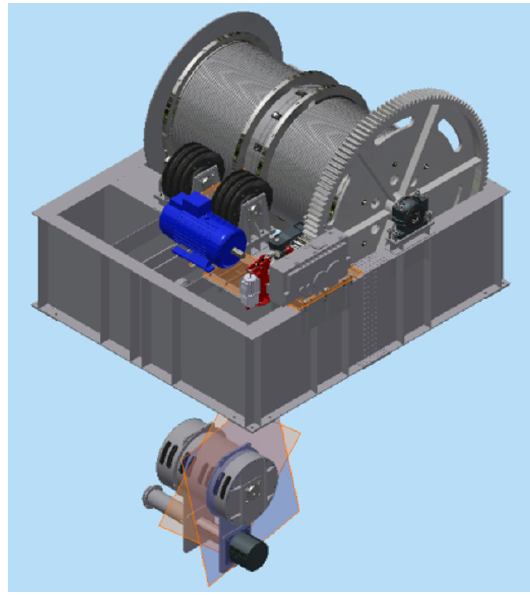
Figure 5. The 3D model of No. 1.